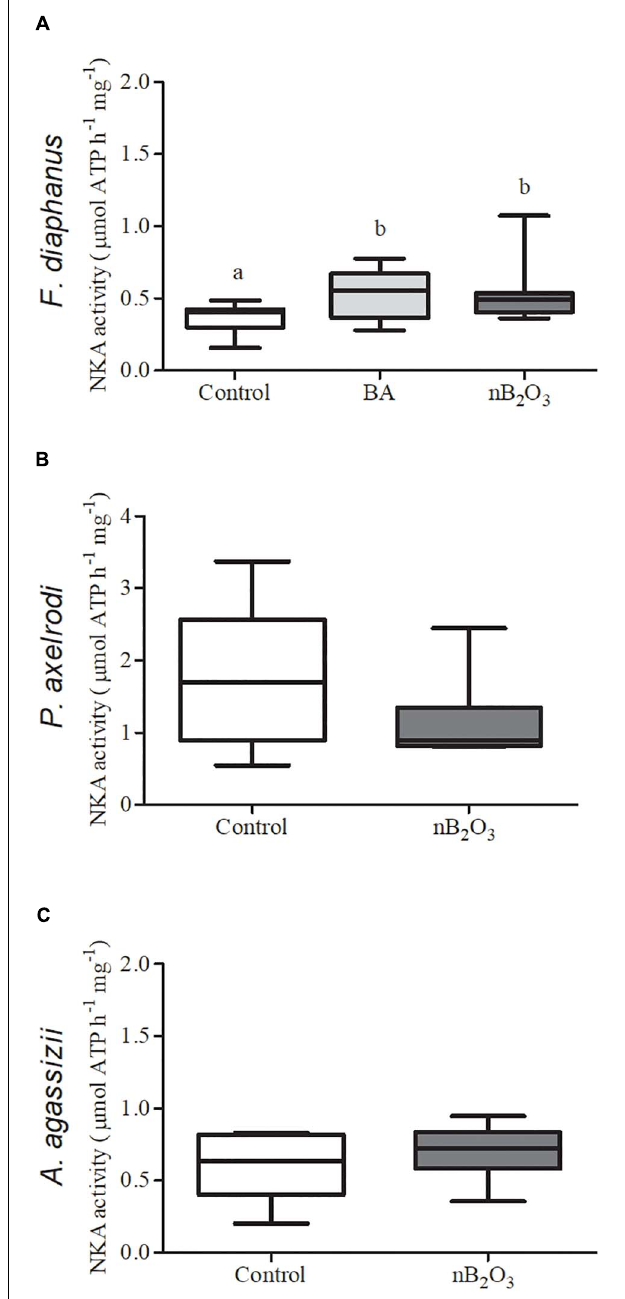
FIGURE 6 | Effects of BA (10 mg L − 1 ) and nB 2 O 3 [1.0 mg L − 1 for Fundulus diaphanus (A) , 10.0 mg L − 1 for Paracheirodon axelrodi (B) ,